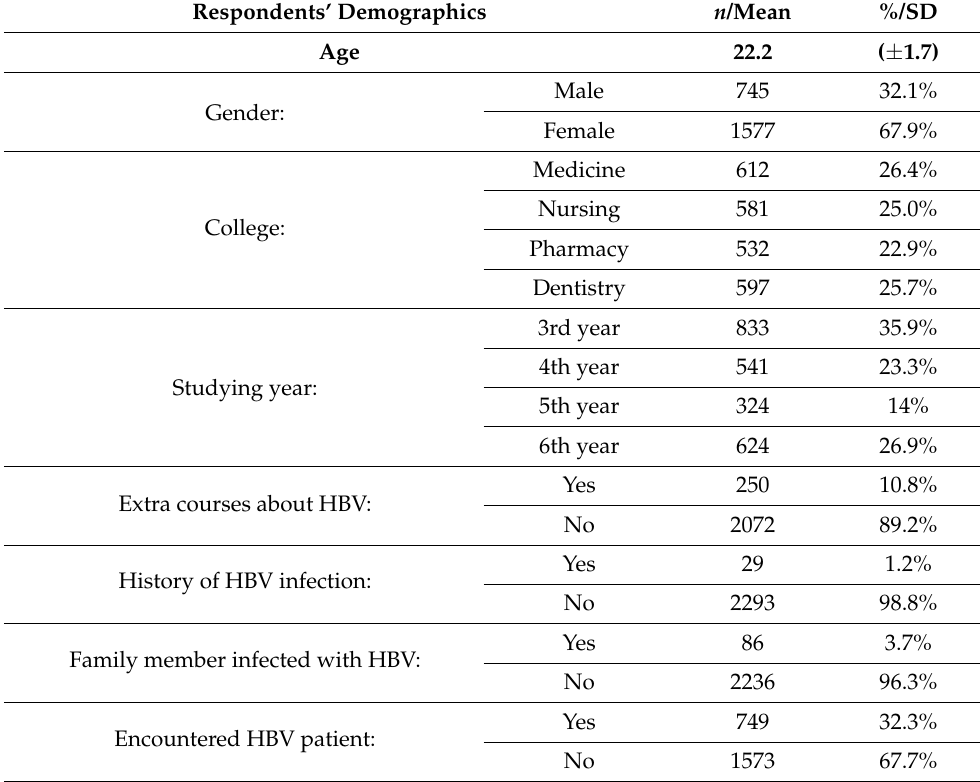
Table 1. Demographics of survey participants ( n = 2322). Respondents’ Demographics n